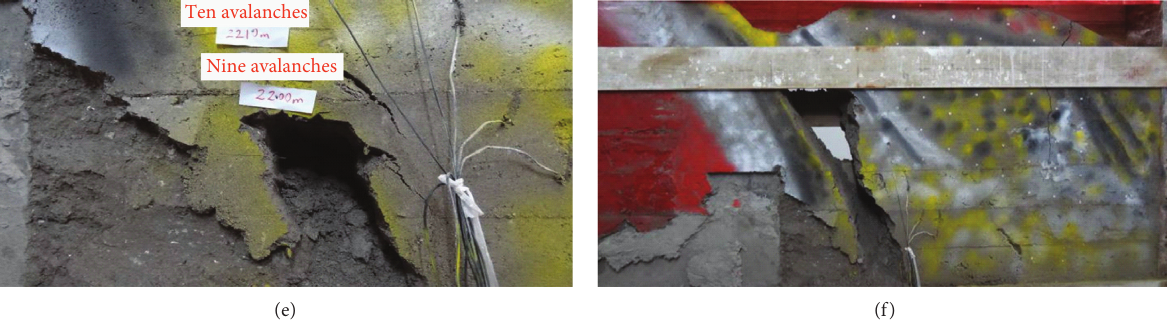
Figure 11: Damage condition of overlying strata after multiexcavations (50 ° ). (a) Model before excavation (50 ° ). (b) Damage condition of overlying strata after the first exploit progress (50 ° ). (c) Damage condition of overlying strata after the fifth exploit progress (50 ° ). (d) Damage condition of overlying strata after the sixth exploit progress (50 ° ). (e) Damage condition of overlying strata after the eighth exploit progress (50 ° ). (f) Damage condition of overlying strata after the tenth exploit progress (50 °